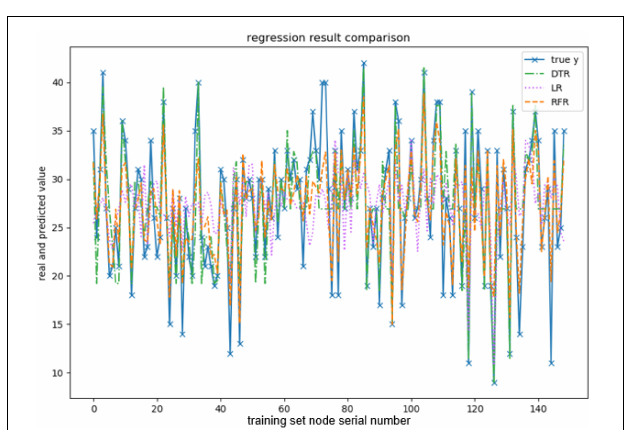
FIGURE 4 | Comparison of the predicted values of conscientiousness.